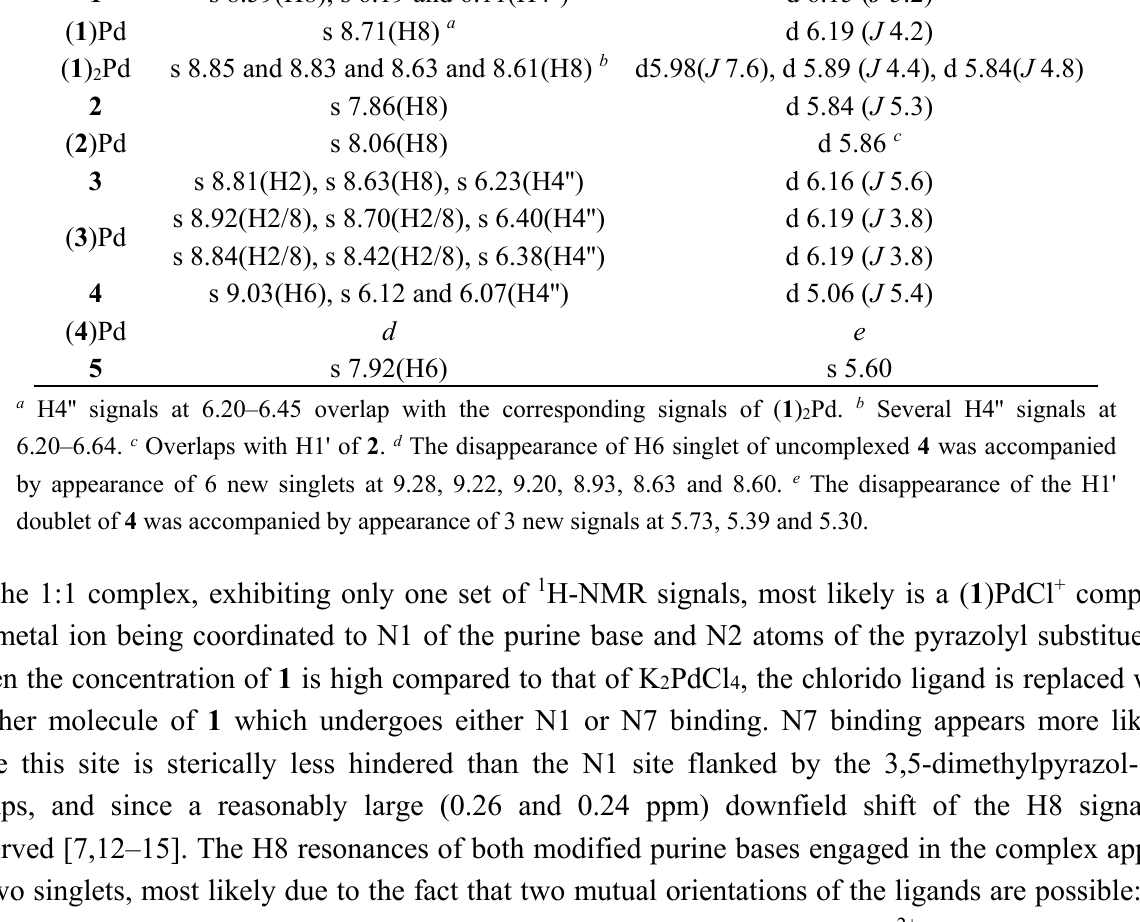
Table 1. Chemical shifts for the aromatic and anomeric protons of the modified nucleosides 1 – 5 and their Pd 2+ complexes in D 2 O at pD 7.6 (0.12 M phosphate buffer, 25 °C).